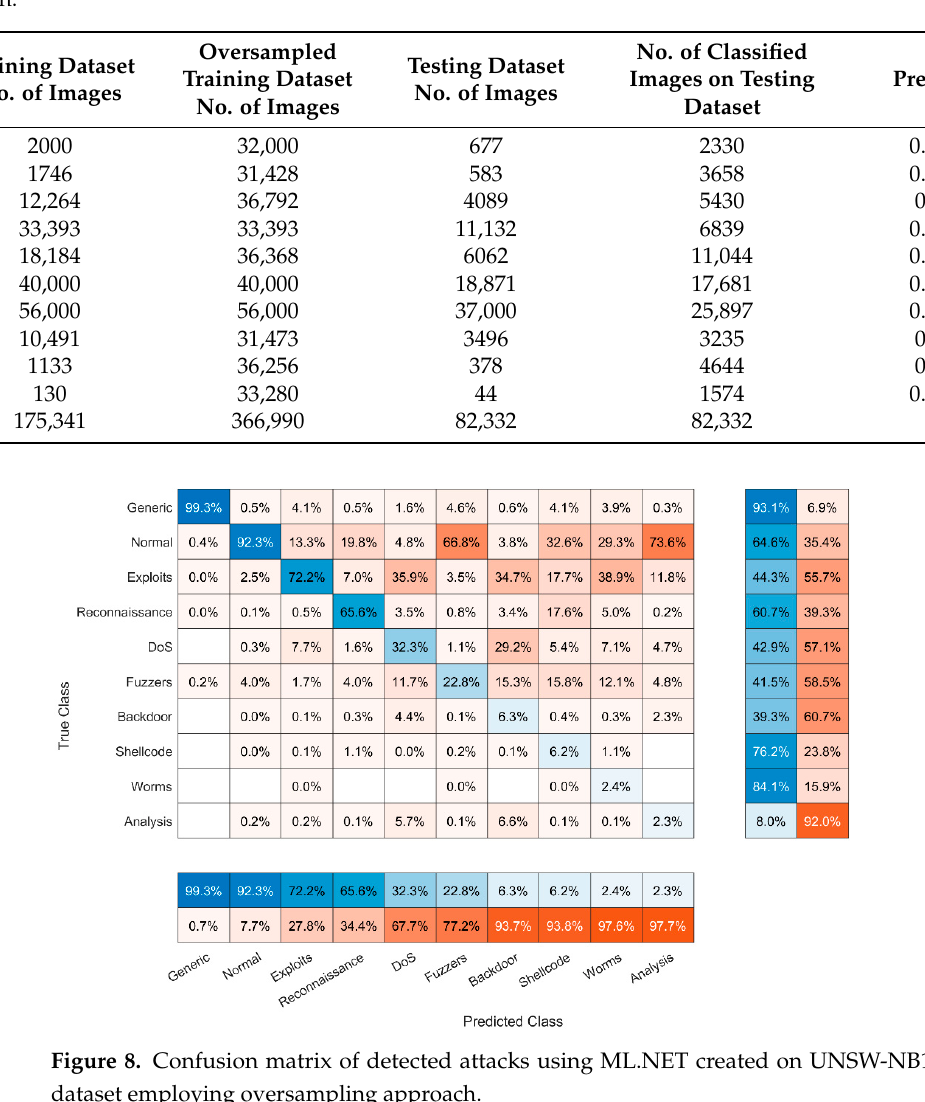
Table 5. Precision of recognized images using ML.NET created model on UNSW-NB15 training dataset employing oversampling approach.